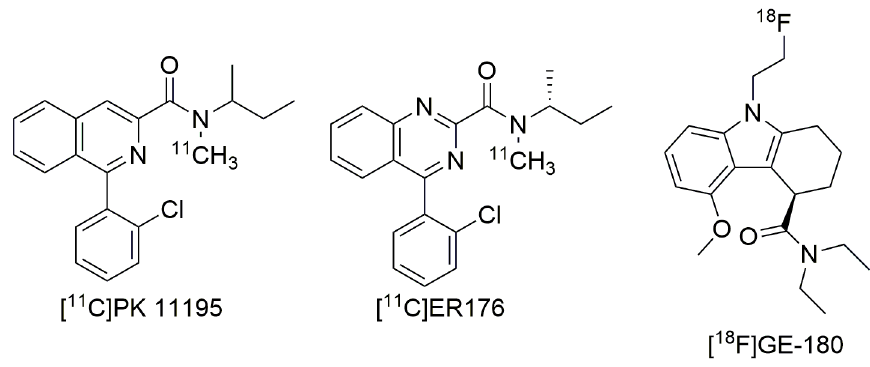
Figure 2. Structures of [ 11 C]PK 11195, [ 11 C]ER176, and [ 18 F]GE-180.